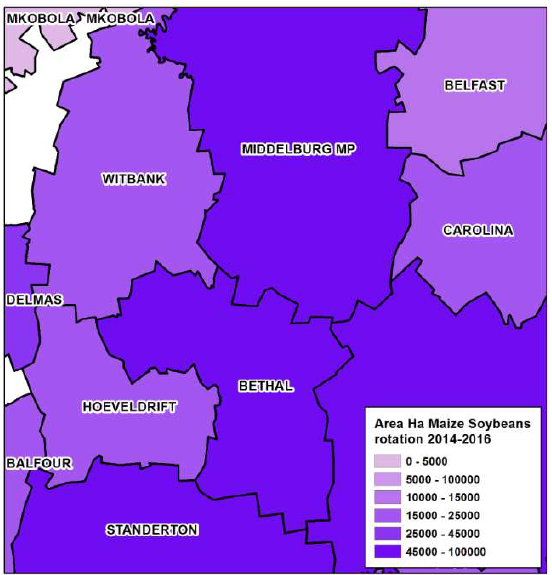
Figure 22. Area Ha of maize and soybeans which were rotated between 2014 and 2016